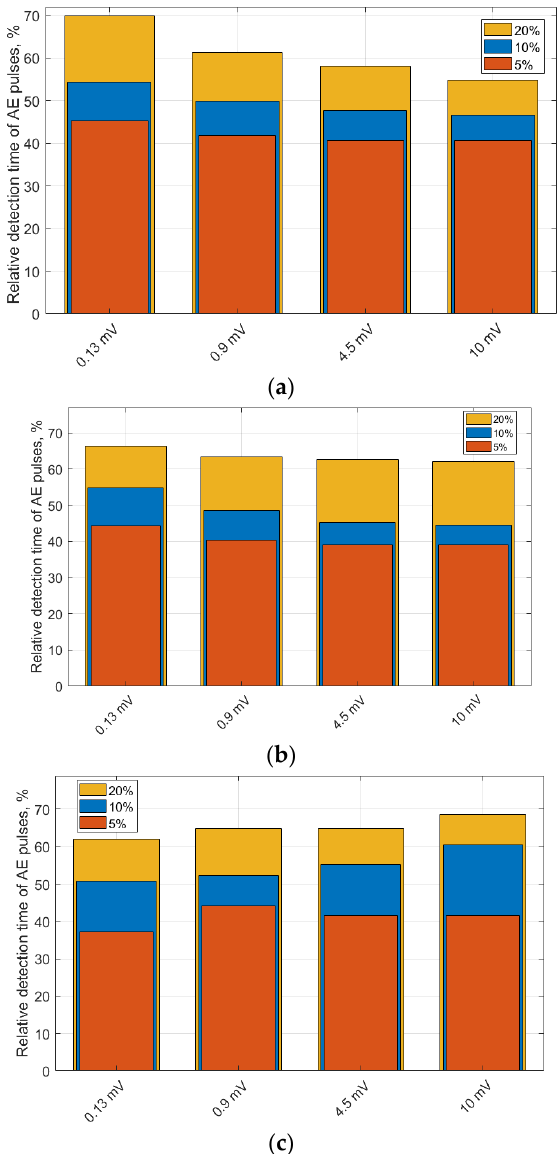
Figure 11. Relative detection time of AE pulses comprising of 5%, 10%, and 20% of the total number of reliably detected pulses at different intensities of the background noise for each of the laboratory samples (uniaxial tension of the woven laminate sample cut along the warp ( a ) and weft ( b ) directions, and the unidirectional CFRP sample ( c ) cut along the fiber direction).